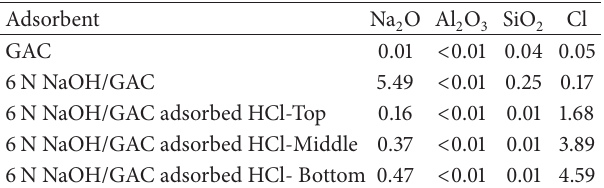
Table 4: Element composition of